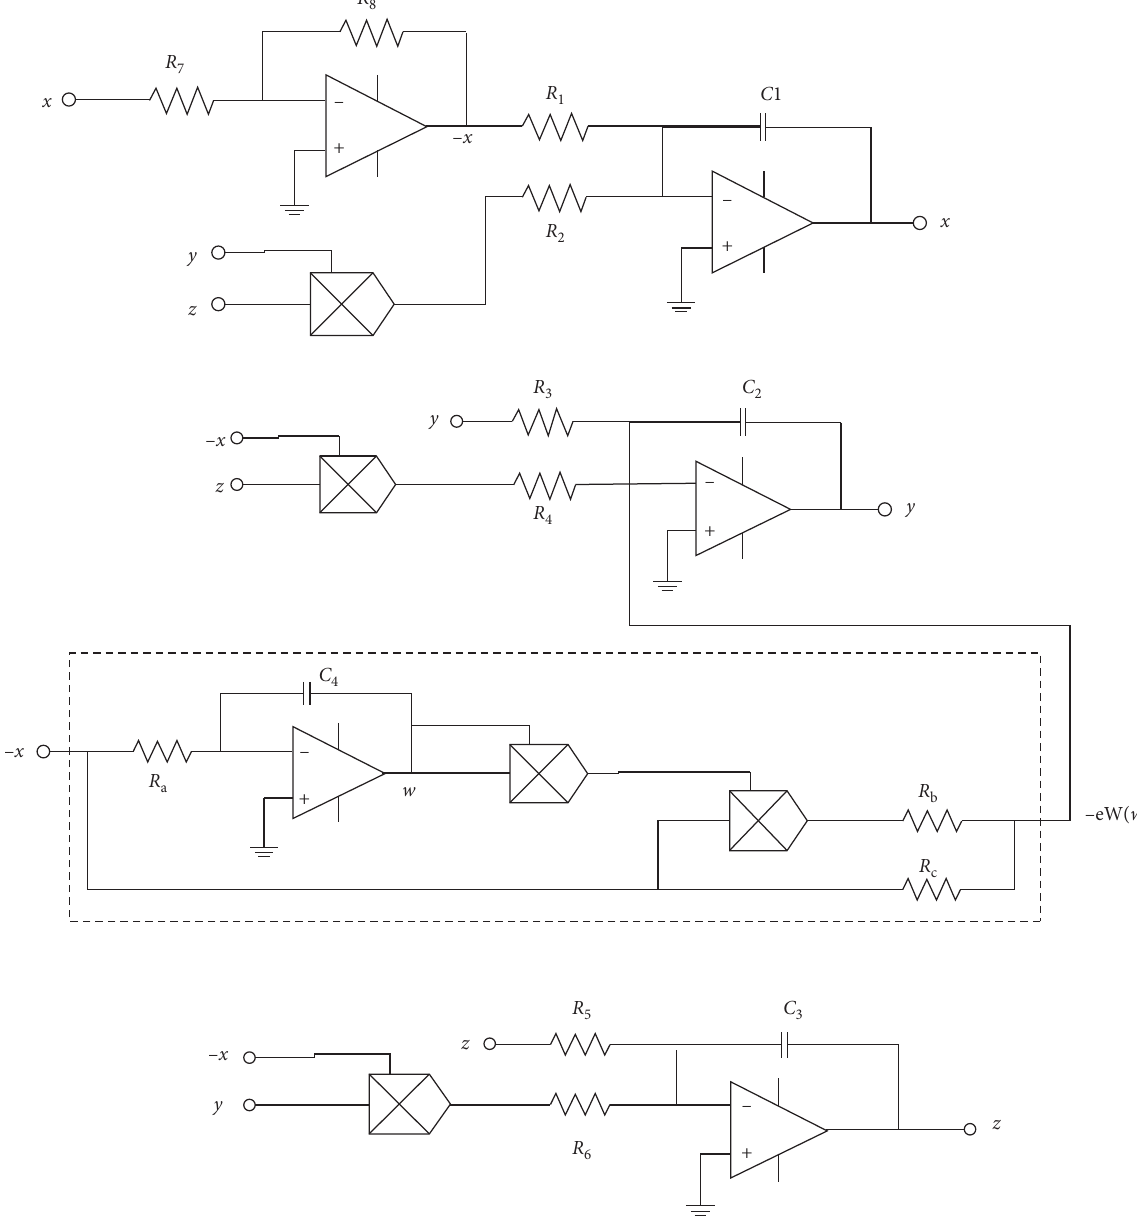
Figure 15: Circuit diagram of memristive system